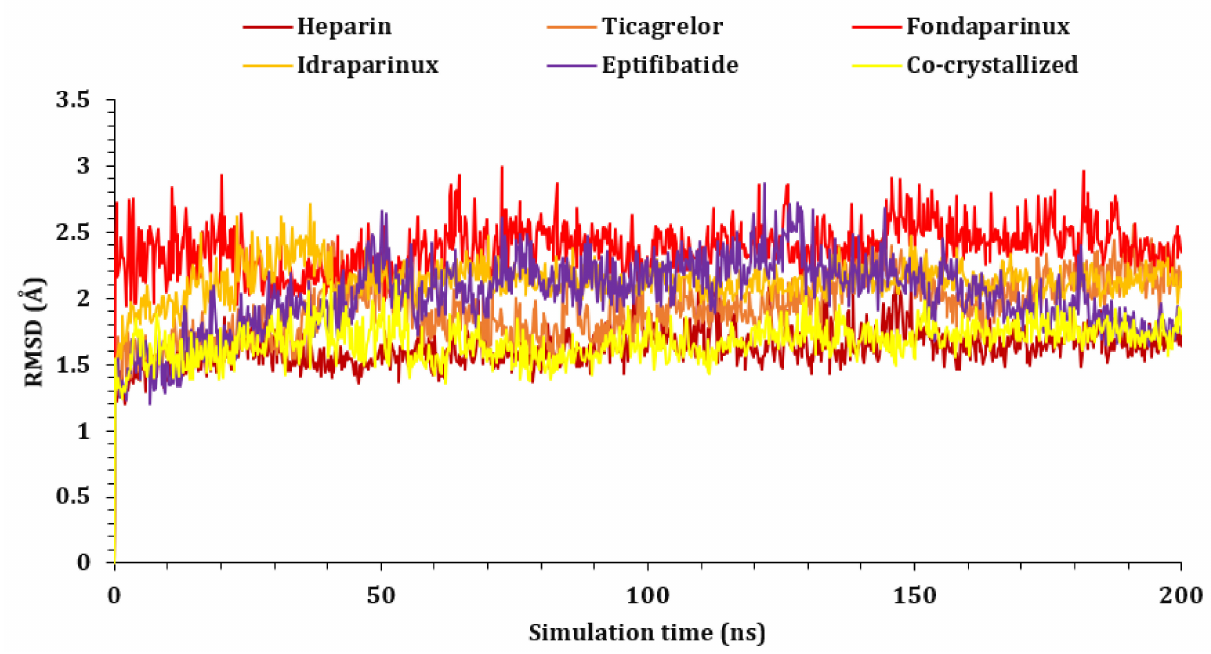
Figure 3. The RMSDs of protein complexes (heparin, ticagrelor, fondaparinux, idraparinux, eptifi- batide, and O6K -6Y2G, respectively) for 200